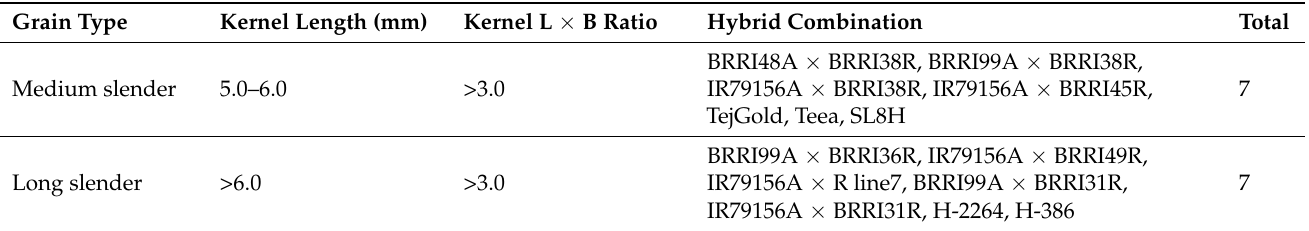
Table 3. Classification of hybrid combinations based on grain